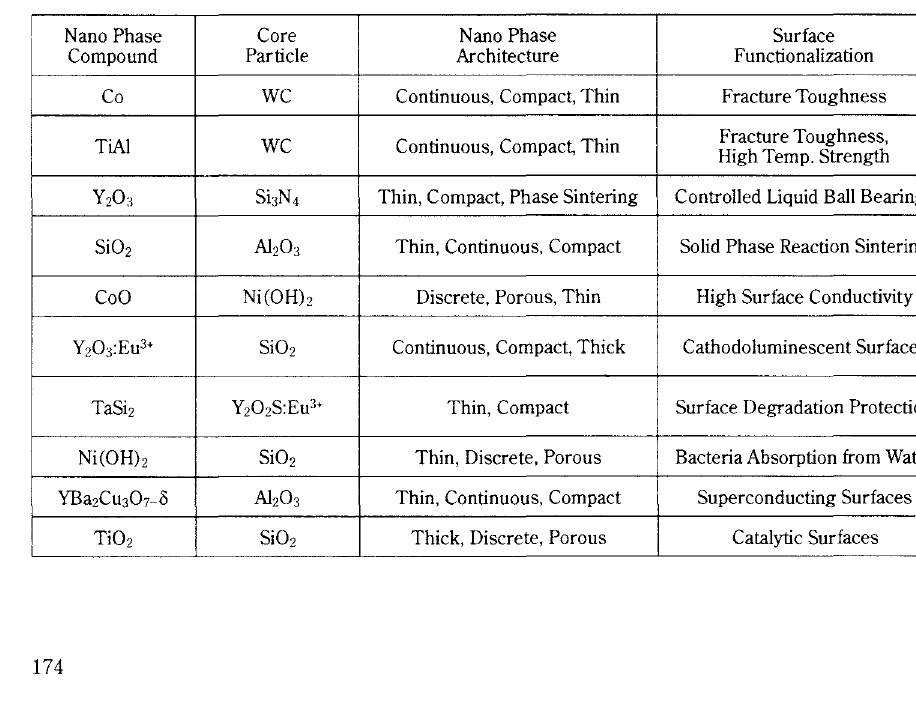
Fig. 1 Schematic diagram of a nanofunctional particulate con· sisting of a core particle coated with nano particles. Fig. 1 (a) illustrates a discrete or porous coating while (b) shows a continuous nanoparticle coating.